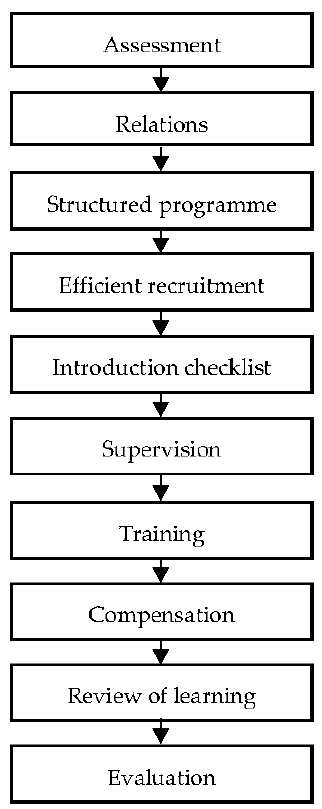
Figure 3. The Guide to quality Work-Based Learning (WBL).